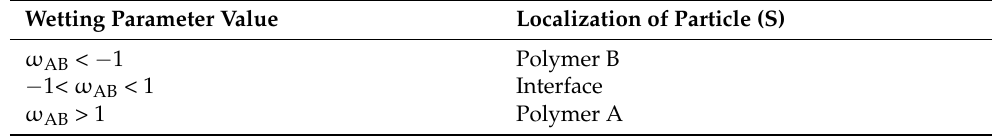
Table 3. Surface tension values of components of the blends .